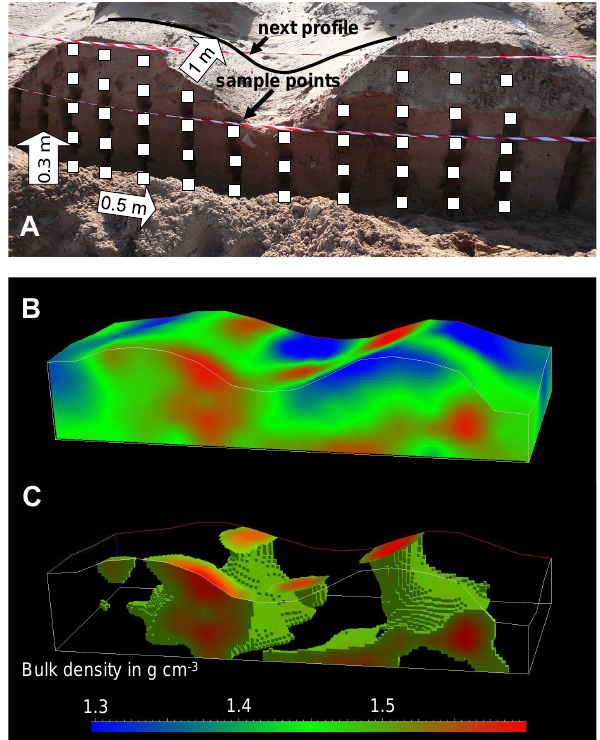
Fig. 9. 3-D soil bulk density distribution obtained from a freshly- dumped spoil cone location: (A) spoil cones during sampling with sampling scheme. (B) 3-D visualization of bulk density after linear interpolation (DSI) in GOCAD. (C) Spoil cone zones with highest bulk densities